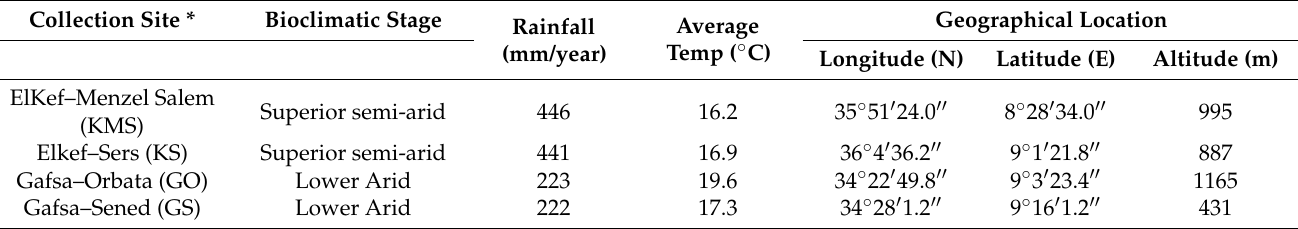
Table 6. Samples collection sites and their eco-geographic characteristics. Bioclimatic Map of Tunisia According to the Classification of Emberger, published by the Tunisian Republic. National Institute of Forest Research. Collection Site